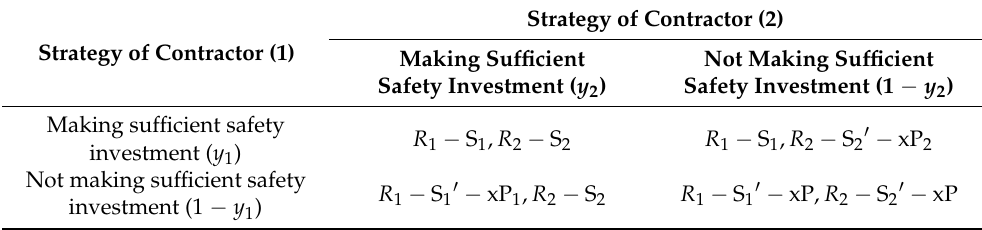
Table 2. Payoff matrix between the two competing contractors.